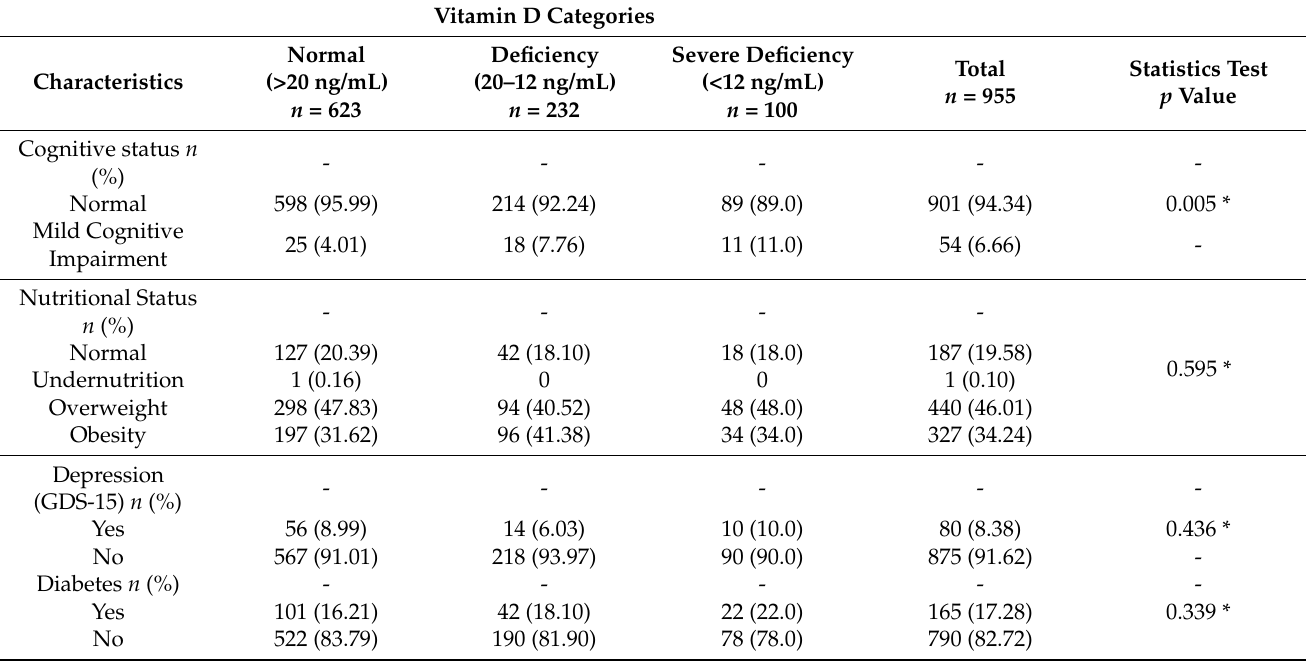
Table 2. Vitamin D status according to cognitive status, nutritional state, depression and diabetes. Vitamin D Categories